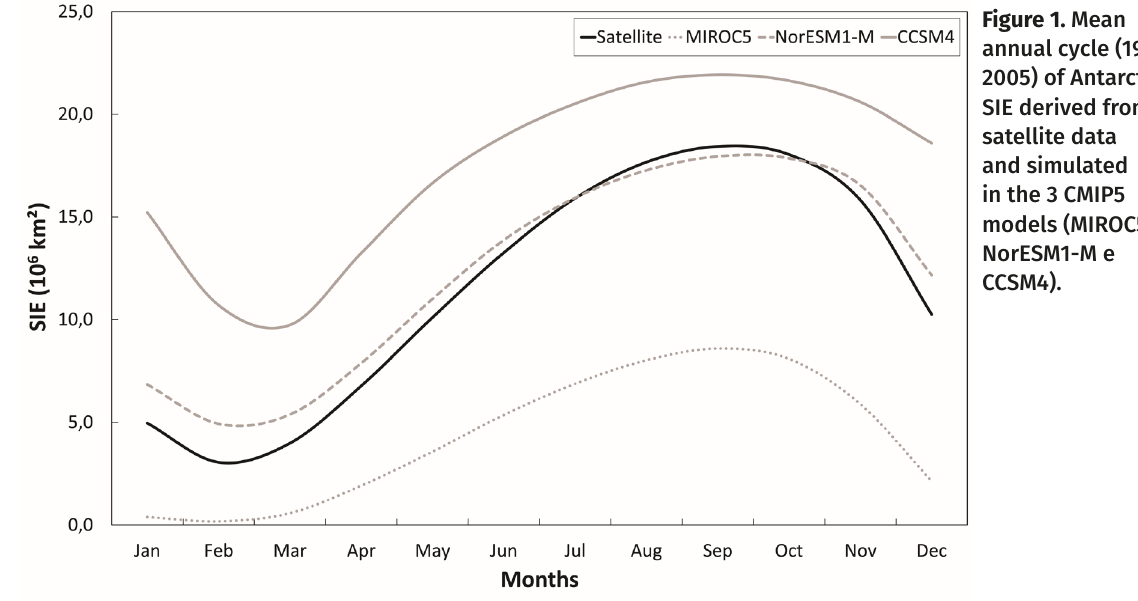
Figure 1. Mean annual cycle (1979- 2005) of Antarctica SIE derived from satellite data and